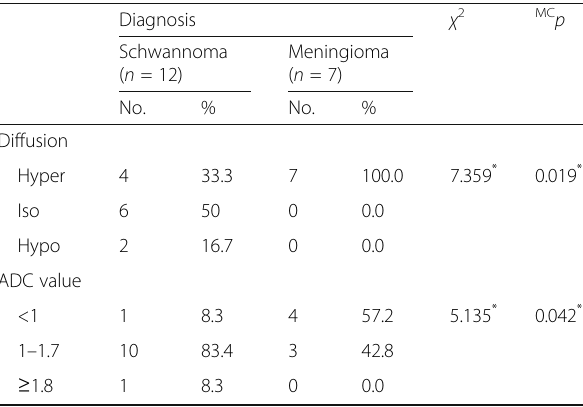
Table 4 Evaluation of different conventional signs of CPA masses Diagnosis χ 2